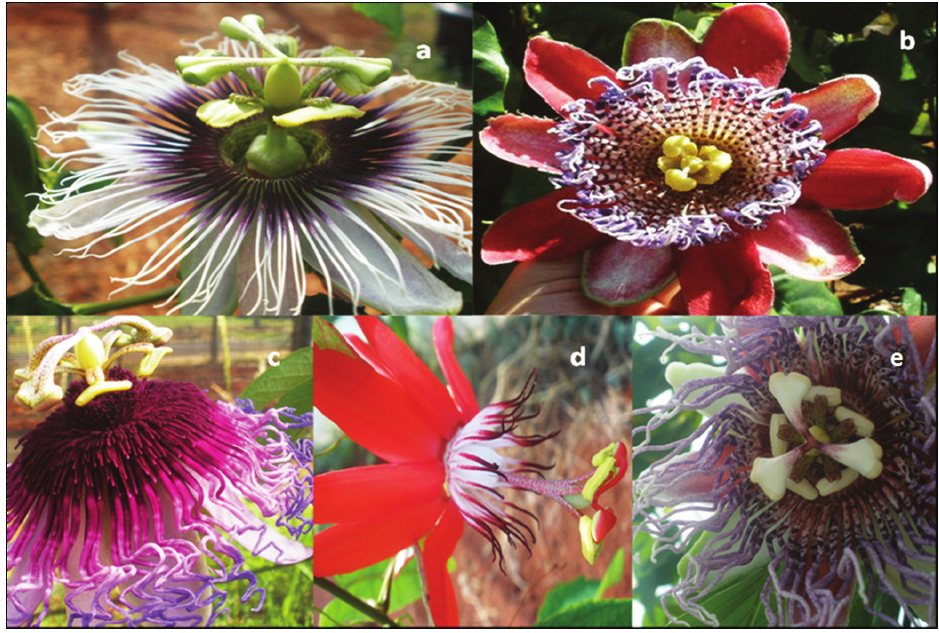
Figure 1 - Species of Passiflora : (a) P. edulis ; (b) P. alata ; (c) P. cincinnata ; (d) P. coccinea ; (e) P. quadrangularis. Photo: Daniel A.V. Montero,